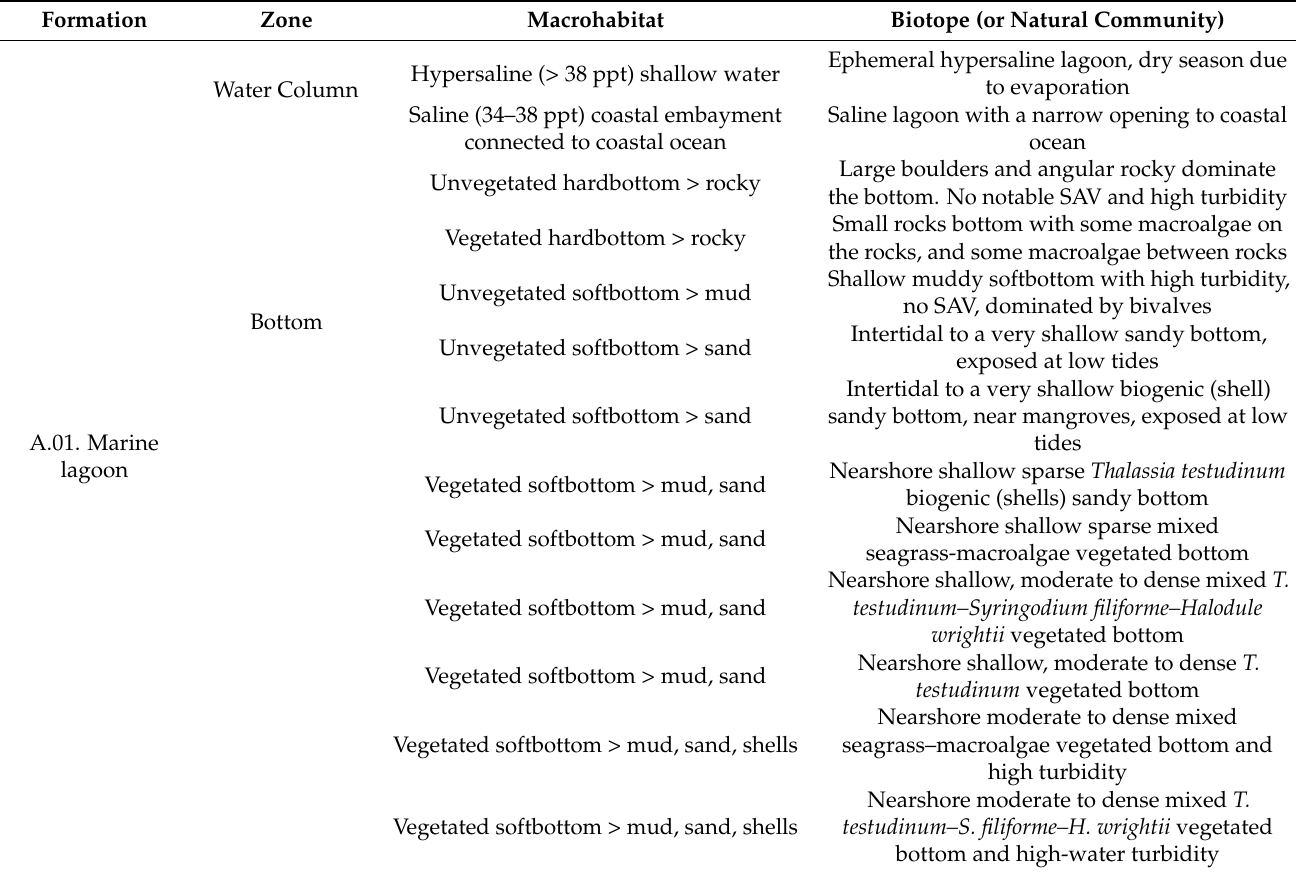
Table 1. Diversity of biotopes in the nearshore marine regime of coastal northeastern Guajira according to the CMECS classification standard